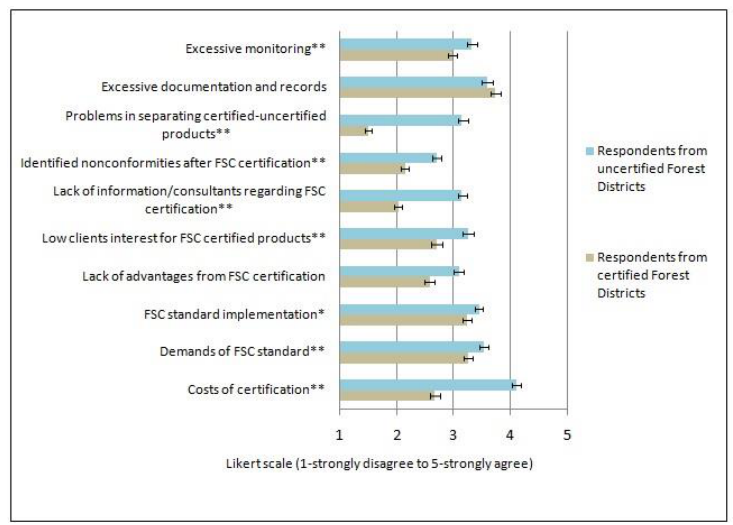
Figure 11. Perception of FDs managers and FDs FSC responsible persons regarding the obstaclesfaced for FSC forest management certification (Mann Whitney U test: * p < 0.05; ** p < 0.01) (Likert scale question: Indicate, on a scale from 1 to 5, the importance of the obstacles faced by your FD for FSC certification) (in Supplementary).